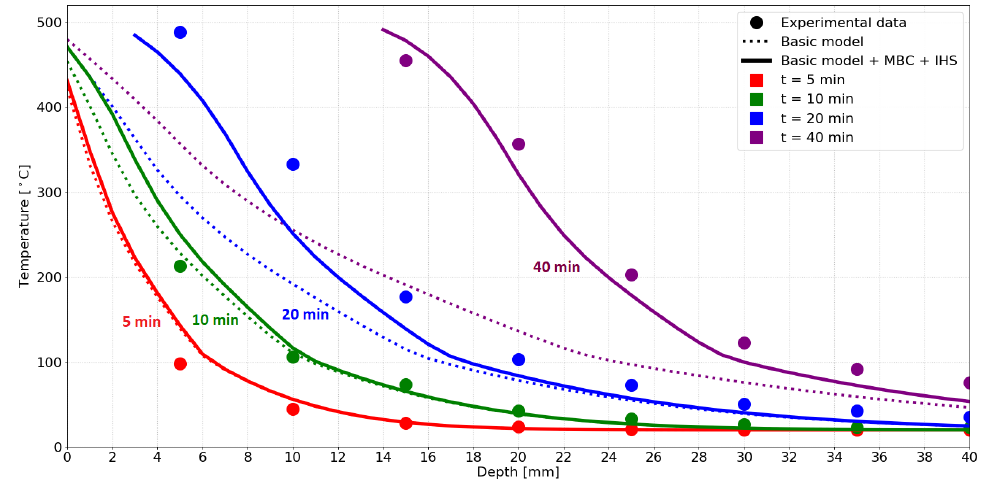
Figure 11. Simulation results compared with experimental data by Reszka and Torero [26].